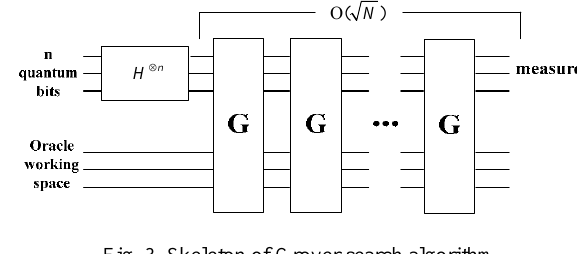
Fig. 3. Skeleton of Grover search algorithm (Step i) Initialization. The Grover search algorithm